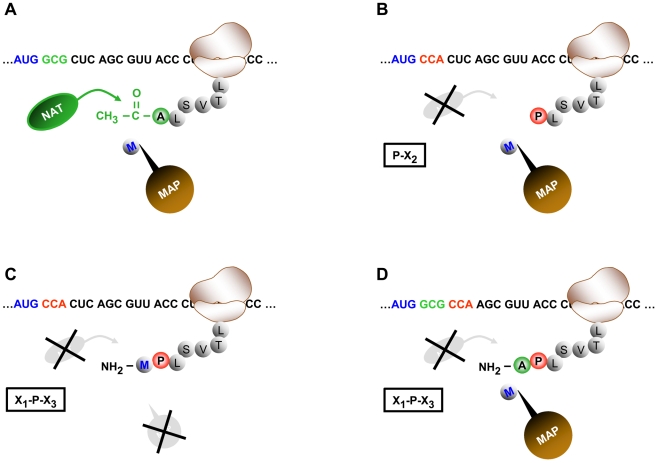
Schematic drawing of the (X)PX rule.(A) During translation of a protein with the sequence Met-Sur at its N-terminus (Sur being a small and uncharged amino acid residue, in this case Sur is equal to an Ala residue in green), the iMet will be removed by a methionine aminopeptidase (MAP, brown bubble) and the processed amino-terminus will be acetylated at the alpha amine of the Ala residue by a NAT (green oval). (B and C) A protein with the sequence Met-Pro at its N-terminus (referred to as Pro-X2, panel B) will undergo iMet cleavage by the methionine aminopeptidase (MAP, brown bubble) and the processed amino-terminus will remain unacetylated. If iMet cleavage is not taking place, proteins with the sequence Met-Pro-X3 at their mature amino-terminus (panel C) will also remain unacetylated. The Pro residue (red) thus prevents acetylation even if iMet cleavage occurs only partially. (D) Similarly, from a protein having the sequence X1-Pro-X3 (X1 being Ala or Ser, in this case Sur is equal to an Ala residue in green, Pro in red), the iMet will be removed and the processed amino-terminus will remain unacetylated (panel D). Although partial removal of the iMet is rarely observed under these circumstances, the N-terminus with the amino acid sequence M-A-P usually remains unacetylated as also observed by SRM measurements.